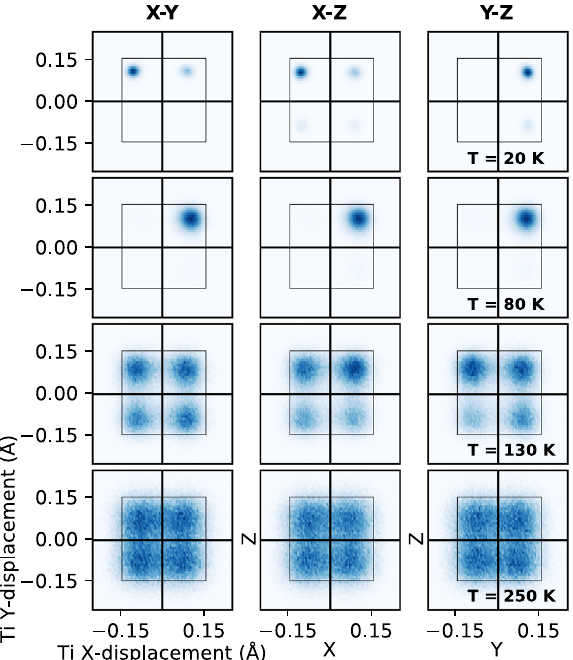
Fig. 3 2D displacement maps, mapped onto the three principal Cartesian planes (X-Y, X-Z, and Y-Z) in a series of NpT 4 × 4 × 4 simulations with restricted cubic geometry. The 20 K trajectory shows fast fast-freezing of the Ti degrees of freedom to the nearest cubic sites (depending on the initial con fi guration) in the fi rst few ps of trajectory. In this speci fi c case, only states corresponding to positive displacements along the y- axis are sampled across the 4 × 4 × 4 supercell. At 80 K the presence of one single maximum in the 3D density marks the onset of a clear “ rhombohedral-like ” ferroelectric state (with a polarization parallel to the [ − 1, + 1, + 1] axis), showing how the GAP favors aligned displacements even in the presence of geometric constraints on the supercell. Simulations at higher temperatures (250 K and beyond) restore instead the eight-site structure of the displacement possible to investigate whether the displacements and ferro- electric states are still observable. Two-dimensional histograms of the Ti-displacements for a series of representative trajectories at 25, 80, 130, and 250 K are provided in Fig. 3. The lowest-temperature trajectory is equivalent to a fast- freezing experiment, where the Ti atoms relax to the closest potential energy minimum. We still observe off-centered states according to the eight-site model picture, but no transitions between neighboring cubic sites take place due to the negligible thermal fl uctuations. By slightly increasing the temperature, the thermal fl uctuations are still smaller than the energy barrier between neighboring cubic sites but are suf fi cient to induce rare jumps between them.